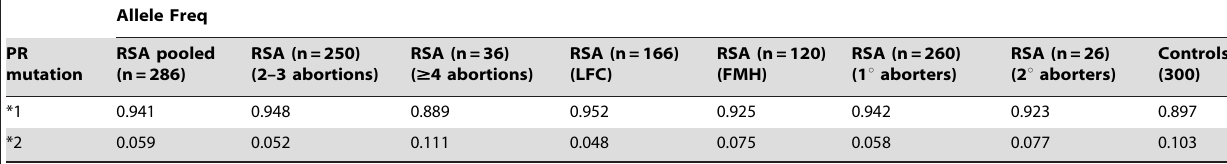
Allele Frequencies of the *1 and the *2 alleles in the RSA women (pooled, 2–3 abortions and 4 or more abortions) and the controls, RSA women from LFC and FMH and in the primary (1 u ) and secondary (2 u ) aborters.